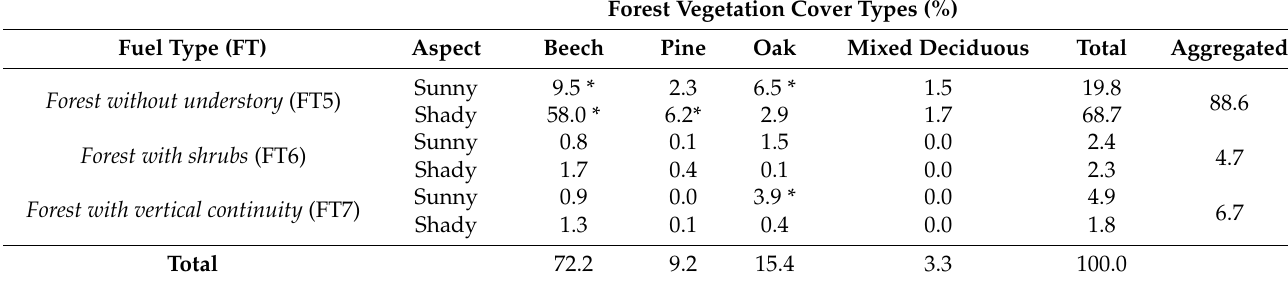
Figure 4. Comparison of a vertical vegetation profile between 2010 (left) and 2016 (right) in a same cell. ( a ) Shows how a vegetation profile changed from forest with shrubs (FT6) in 2010 to forest with no understory (FT5) in 2016. ( b ) Displays the transition from forest with no understory (FT5) in 2010 to forest with vertical continuity (FT7) in 2016. Colors signify strata: above 4.0 m (red), 2.0–4.0 m (yellow), Table 6. Observed frequencies of the following factors: forest fuel type (FT; FT5, FT6, and FT7), forest vegetation cover type (beech, pine, oak and mixed deciduous) and aspect (sunny and shady) in 2016 in the study area. Statistically significant frequencies ( p < 0.05) have been identified with an asterisk (*). Forest Vegetation Cover Types